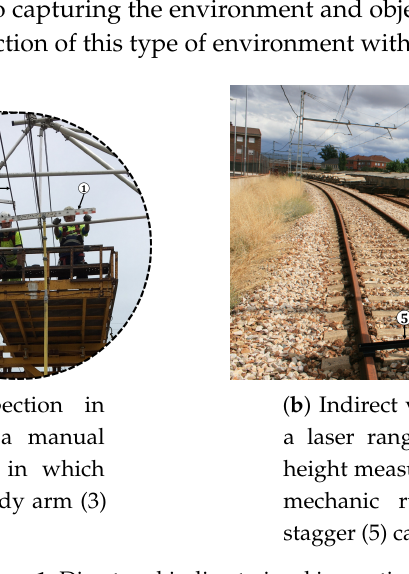
Figure 1. Direct and indirect visual